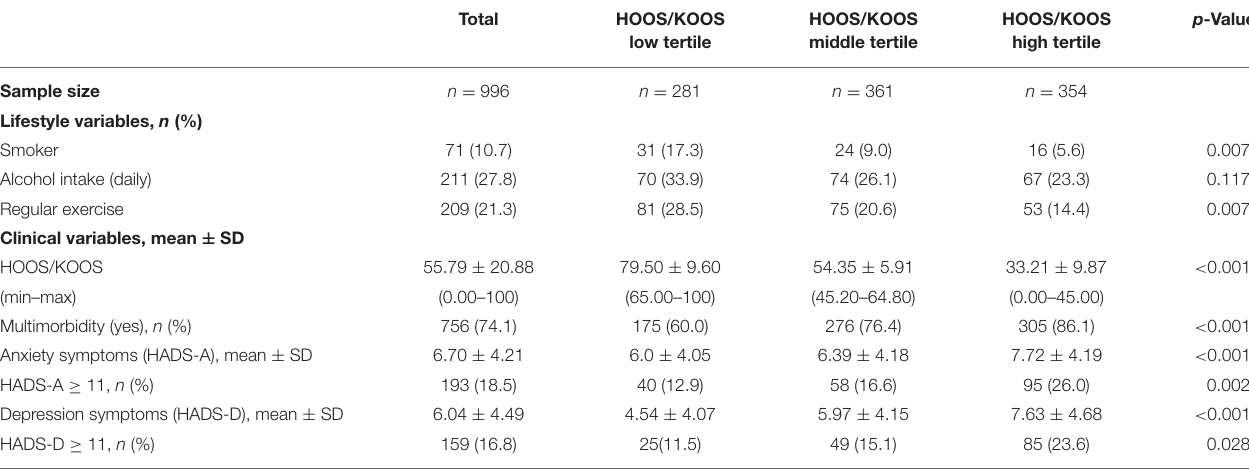
TABLE 3 | Lifestyle and clinical characteristics of participants with HKOA by clinical severity.